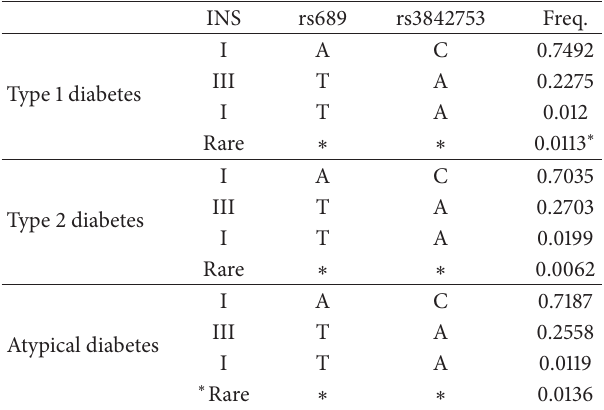
Table 3: Haplotype frequencies for all groups.